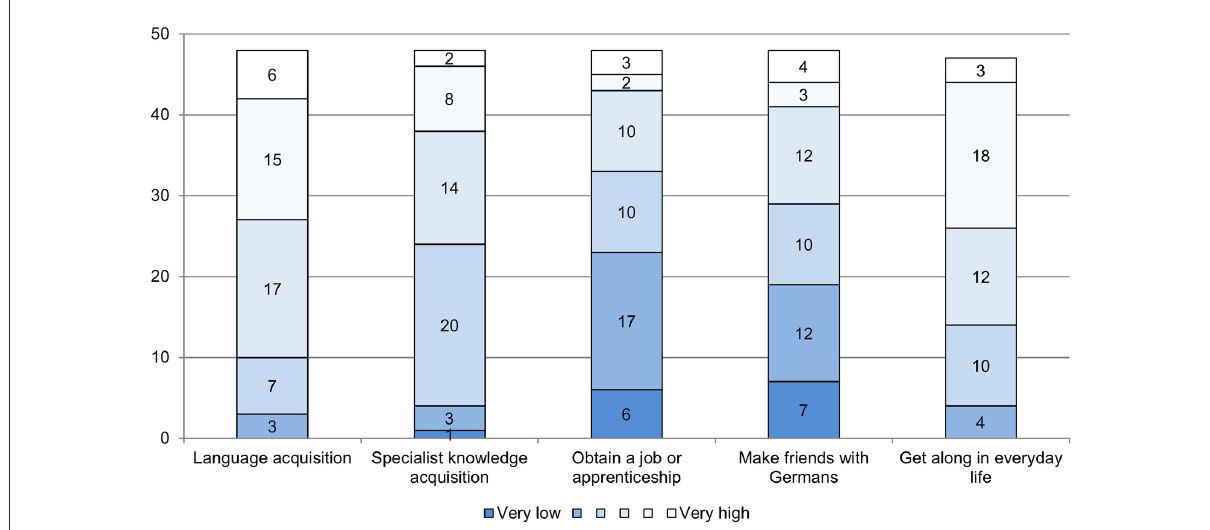
FIGURE4 Assessment of students‘ chances of success in integration (absolute frequencies; scale from 1 = very low to 6 = very high; source: survey of teachers in preparation classes, n =